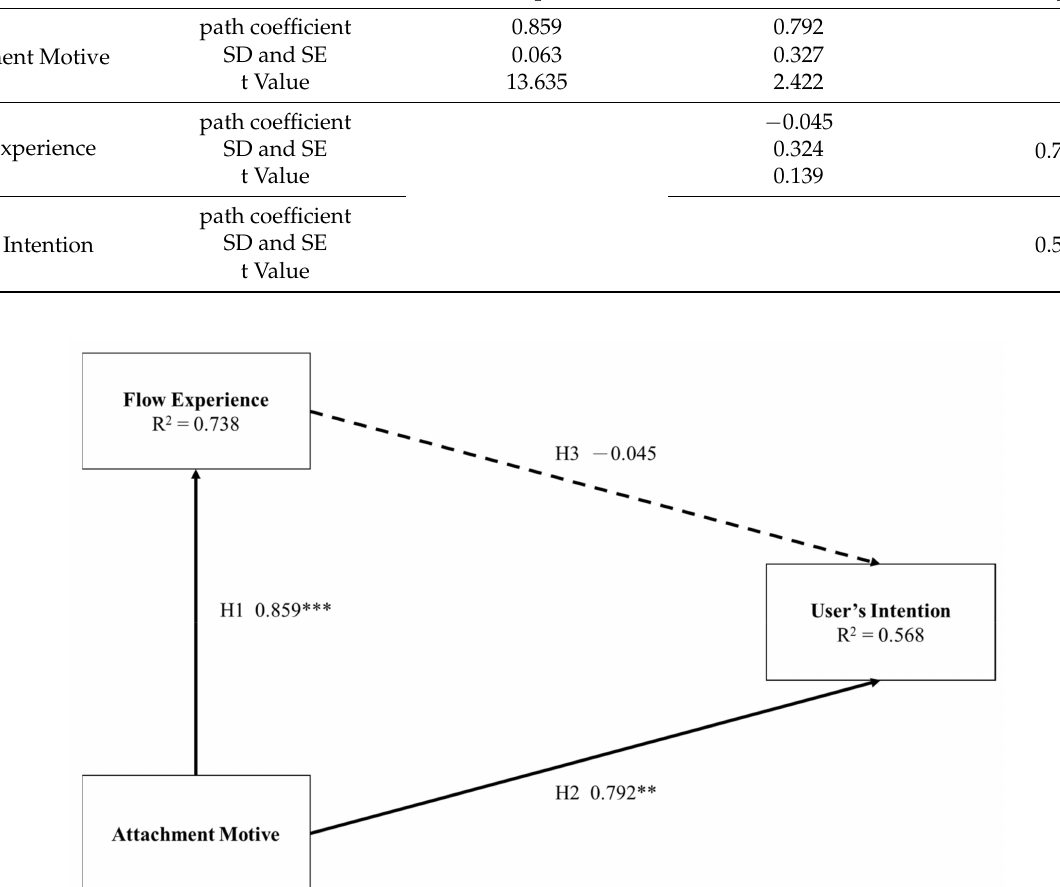
Figure 1. Results of research model. ** p < 0.01; *** p < 0.001.